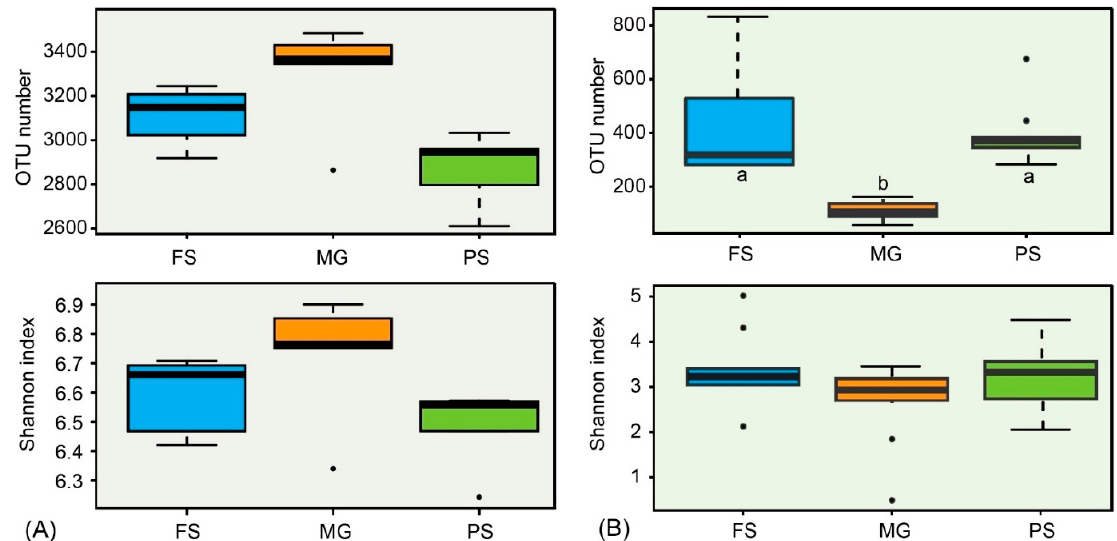
Figure 3. Alpha diversity metrics of prokaryotes ( A ) and microbial eukaryotes ( B ) from samples extracted using the FS, MG, and PS kits. Species richness and diversity were estimated based on the OTU numbers and Shannon index for each method. Different letters above/below the box indicate they are statistically different ( p < 0.001).